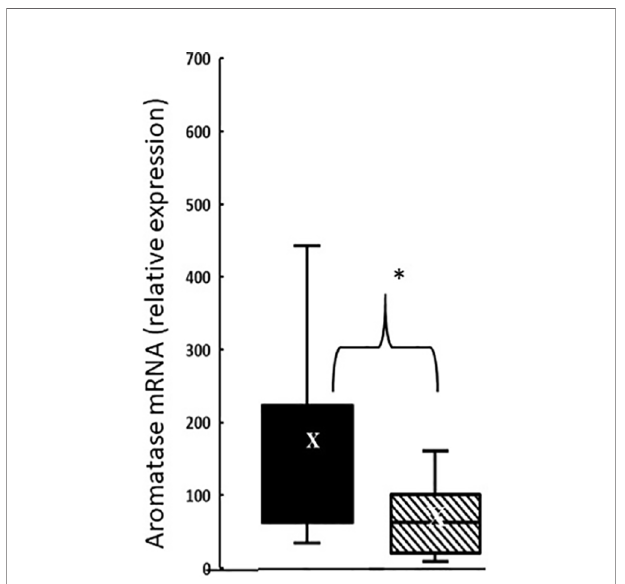
FIGURE 10 | Aromatase expression at postnatal day 7 in splenic epithelium/ stroma from FCG gonadal males versus gonadal females. Expression is normalized to GAPDH. Data are presented as a box and whisker plot and X denotes the mean. N = 13 male (both XYM and XXM) pups (solid bars); n = 11 female (both XXF and XYF) pups (cross-hatched bars). Males different from females, *p < 0.05, effect size